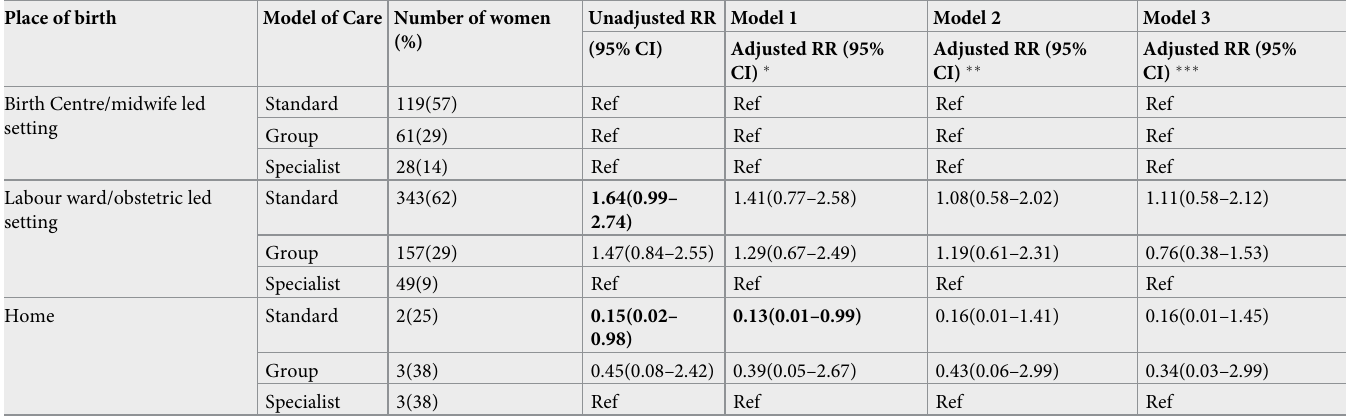
� Model 1: Adjusted for demographics ethnicity, age, parity, IMD score, any social and medical risk factors at booking and onset of labour. �� Model 2: Model 1 + Adjustment for place of antenatal care (community or hospital). ��� Model 3: Model 2 + Adjustment for service provider attended (A or